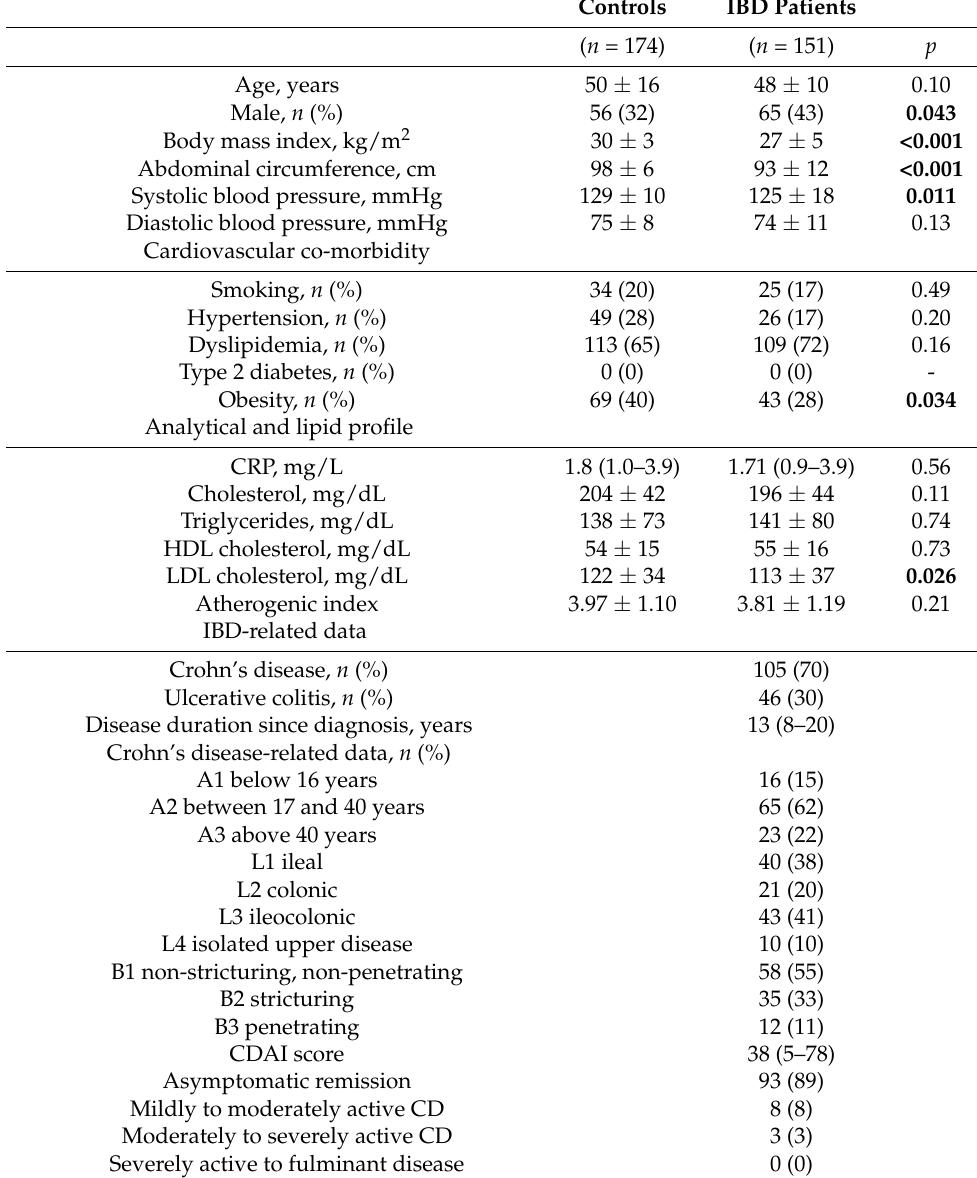
Table 1. Characteristics of IBD patients and